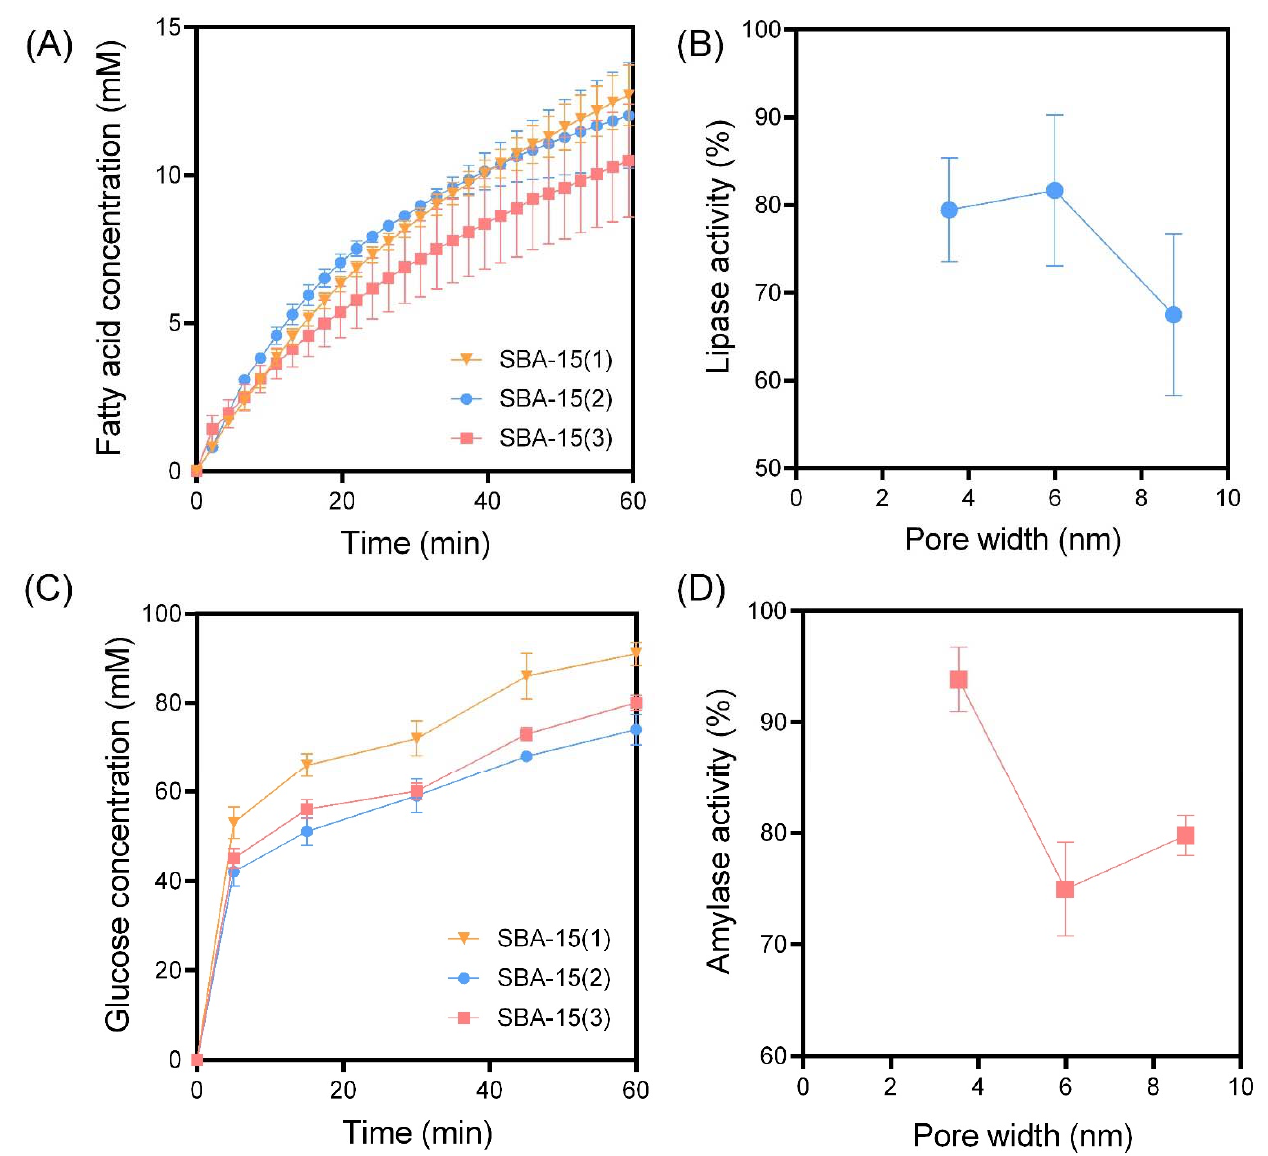
Figure 5. ( A ) In vitro lipid digestion profiles for SBA-15 mesoporous silica with contrasting pore size distributions. ( B ) The impact of SBA-15 pore size on lipase activity. ( C ) In vitro starch digestion profiles for various SBA-15 samples and ( D ) the corresponding impact of SBA-15 pore size on amylase activity. In vitro digestion studies were performed under simulated fed state conditions, with data representing the digestion occuring during the intestinal phase (pH 6.0). Data represent mean ± S.D. ( n = 3).